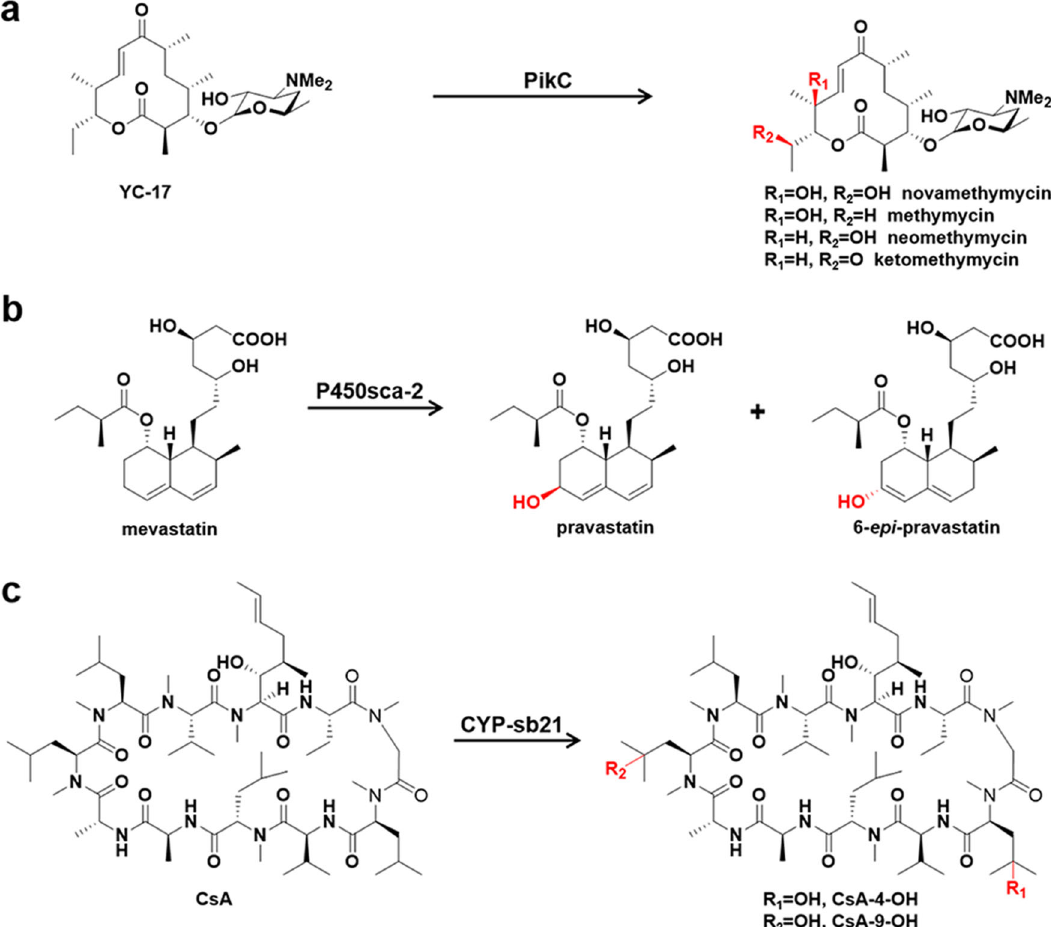
Fig. 1 The P450-catalyzed reactions. a PikC hydroxylates YC-17 to produce the mono-hydroxylated products methymycin and neomethymycin, and two dioxygenation products novamethymycin and ketomethymycin. b P450sca-2 hydroxylates mevastatin to form pravastatin and 6- epi -pravastatin. c CYP- sb21 catalyzes the oxidation of cyclosporine A (CsA) to γ -hydroxy- N -methyl-L-Leu4-CsA (CsA-4-OH) and γ -hydroxy- N -methyl-L-Leu9-CsA (CsA-9-OH). Functional groups and bonds colored in red are catalyzed by the P450s.